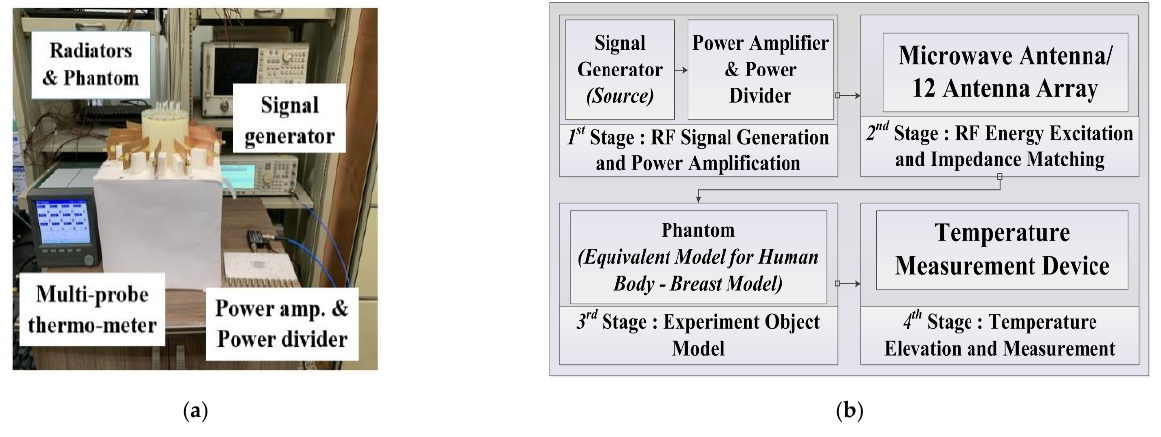
Figure 11. ( a ) Configuration of the temperature measurement setup, and ( b ) block diagram of the temperature measuring system [25].